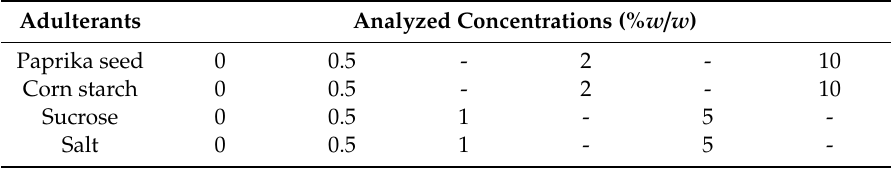
Table 1. Electronic tongue measurement